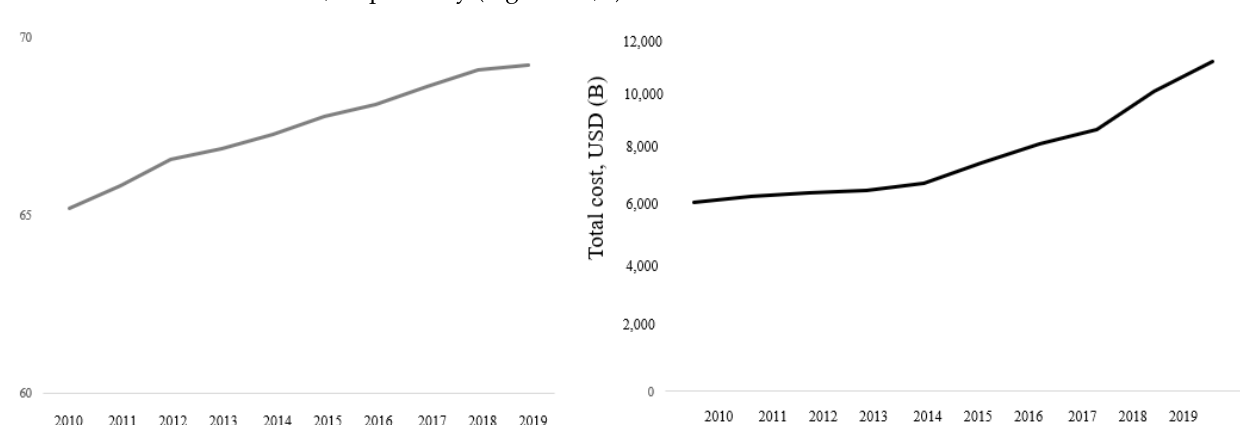
Figure 3. Trends of use of CRRT ( A ) and ECMO ( B ) among patients admitted to the ICU from 2010 to 2019. ECMO, extracorporeal membrane oxygenation; CRRT, continuous renal replacement ther- apy. 3.4. In-Hospital Mortality and 1-Year Mortality Table 3 shows the results of the multivariate logistic regression model for in-hospital mortality among patients admitted to the ICU in South Korea from 2010 to 2019. Older age (aOR: 1.03, 95% CI: 1.03–1.03; p < 0.001), male sex (aOR: 1.08, 95% CI: 1.07–1.08; p < 0.001), increased CCI (aOR: 1.08, 95% CI: 1.08–1.09; p < 0.001), admission from IM (aOR: 1.82, 95% CI: 1.80–1.83; p < 0.001), admission through ER (aOR: 1.39, 95% CI: 1.37–1.40; p < 0.001), mechanical ventilatory support (aOR: 8.41, 95% CI: 8.34–8.48; p < 0.001), ECMO support (aOR: 2.86, 95% CI: 2.77–2.95; p < 0.001), and CRRT use (aOR: 4.38, 95% CI: 4.32– 4.44; p < 0.001) were associated with increased in-hospital mortality. However, compared with the Medical Aid program group, the Q1 (aOR: 0.89, 95% CI: 0.87–0.90; p < 0.001), Q2 (aOR: 0.90, 95% CI: 0.89–0.91; p < 0.001), Q3 (aOR: 0.86, 95% CI: 0.85–0.87; p < 0.001), and Q4 groups (aOR: 0.83, 95% CI: 0.82–0.84; p < 0.001) of household income showed decreased in-hospital mortality. Moreover, patients who were employed at ICU admission showed lower in-hospital mortality than those who were unemployed (aOR: 0.95, 95% CI: 0.94– 0.96; p < 0.001). Table 4 also shows the results of the multivariate Cox regression model for 1-year mortality among patients admitted to the ICU in South Korea from 2010 to 2019.